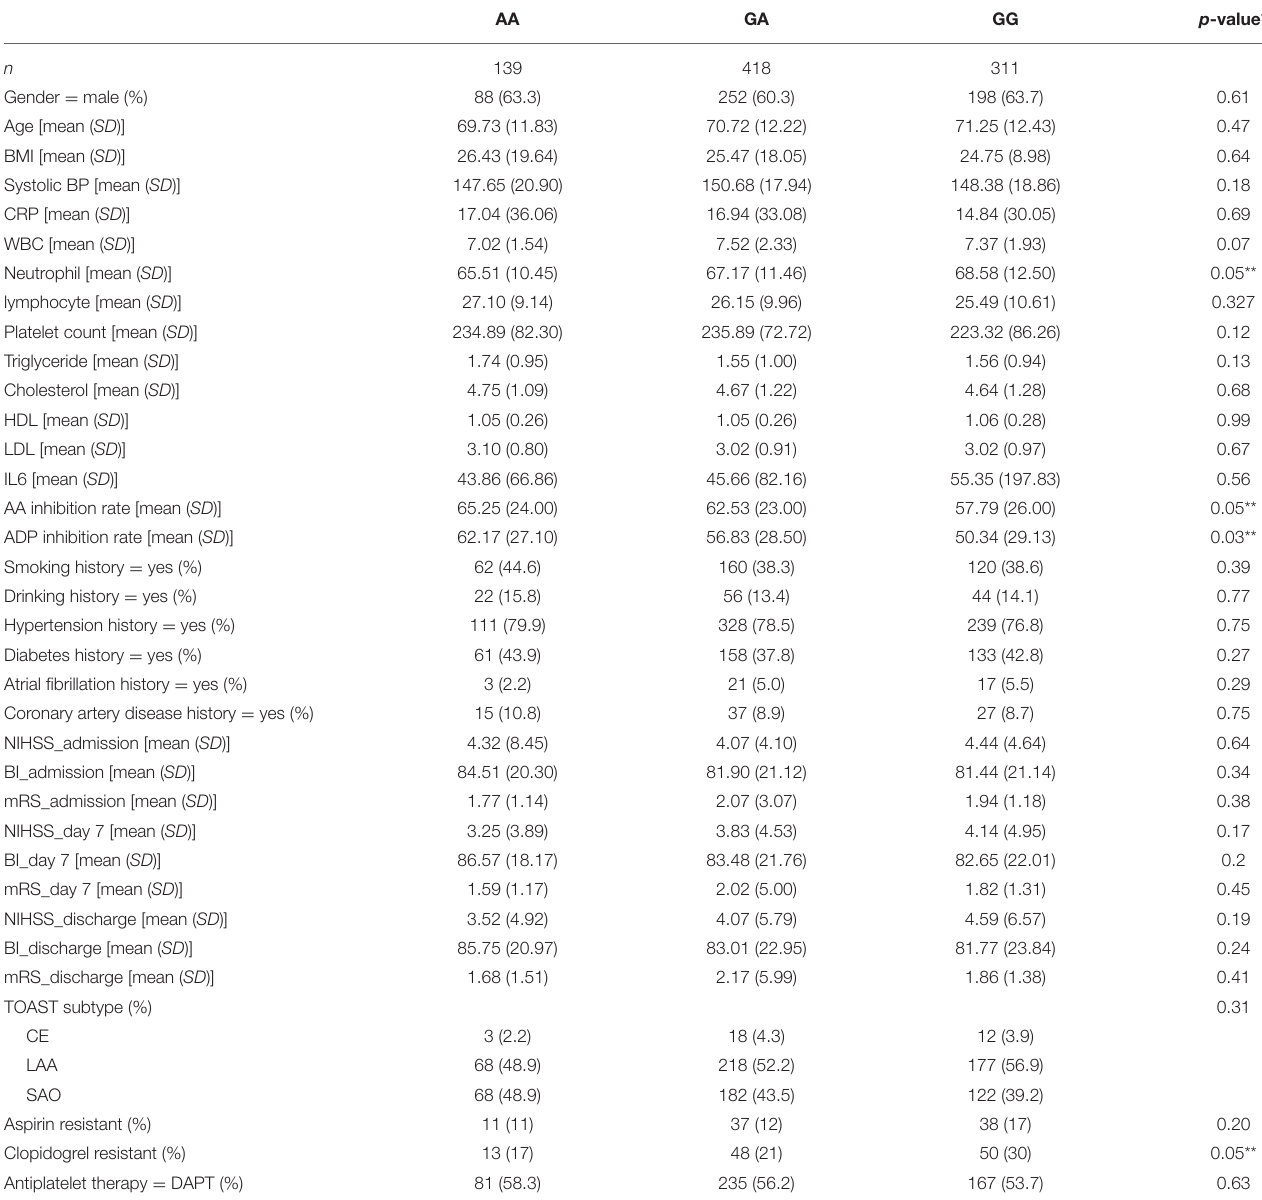
TABLE 1 | Characteristics of patients by PEAR1 rs12041331 SNP. AA GA GG p